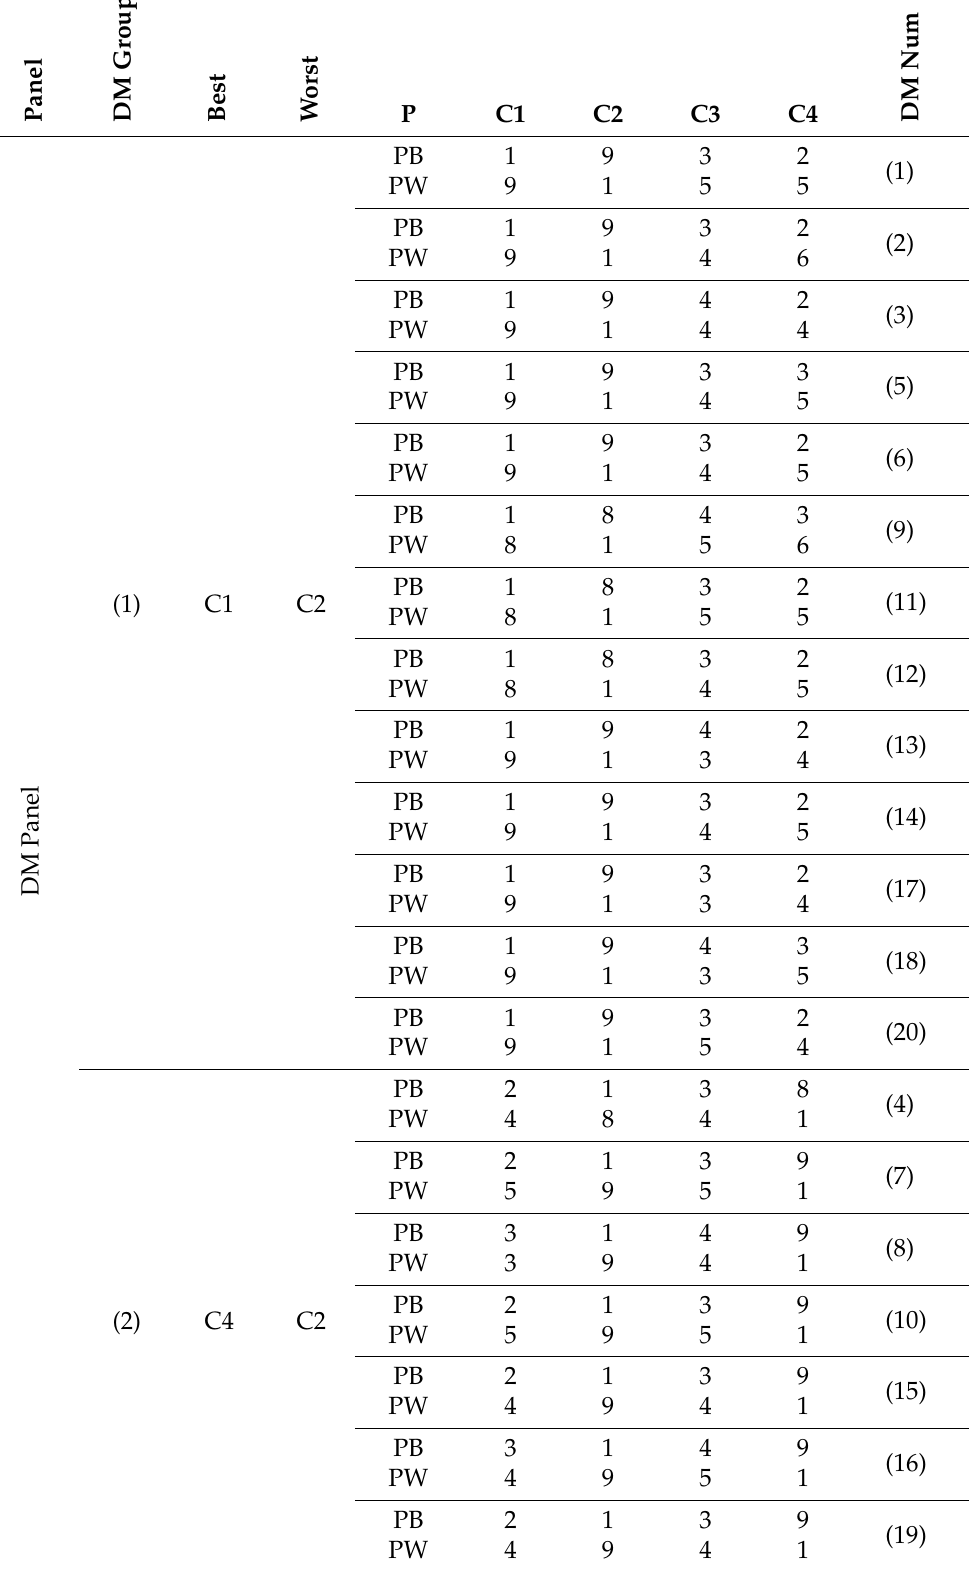
Table 5. Pairwise comparison vector for the best and worst willingness